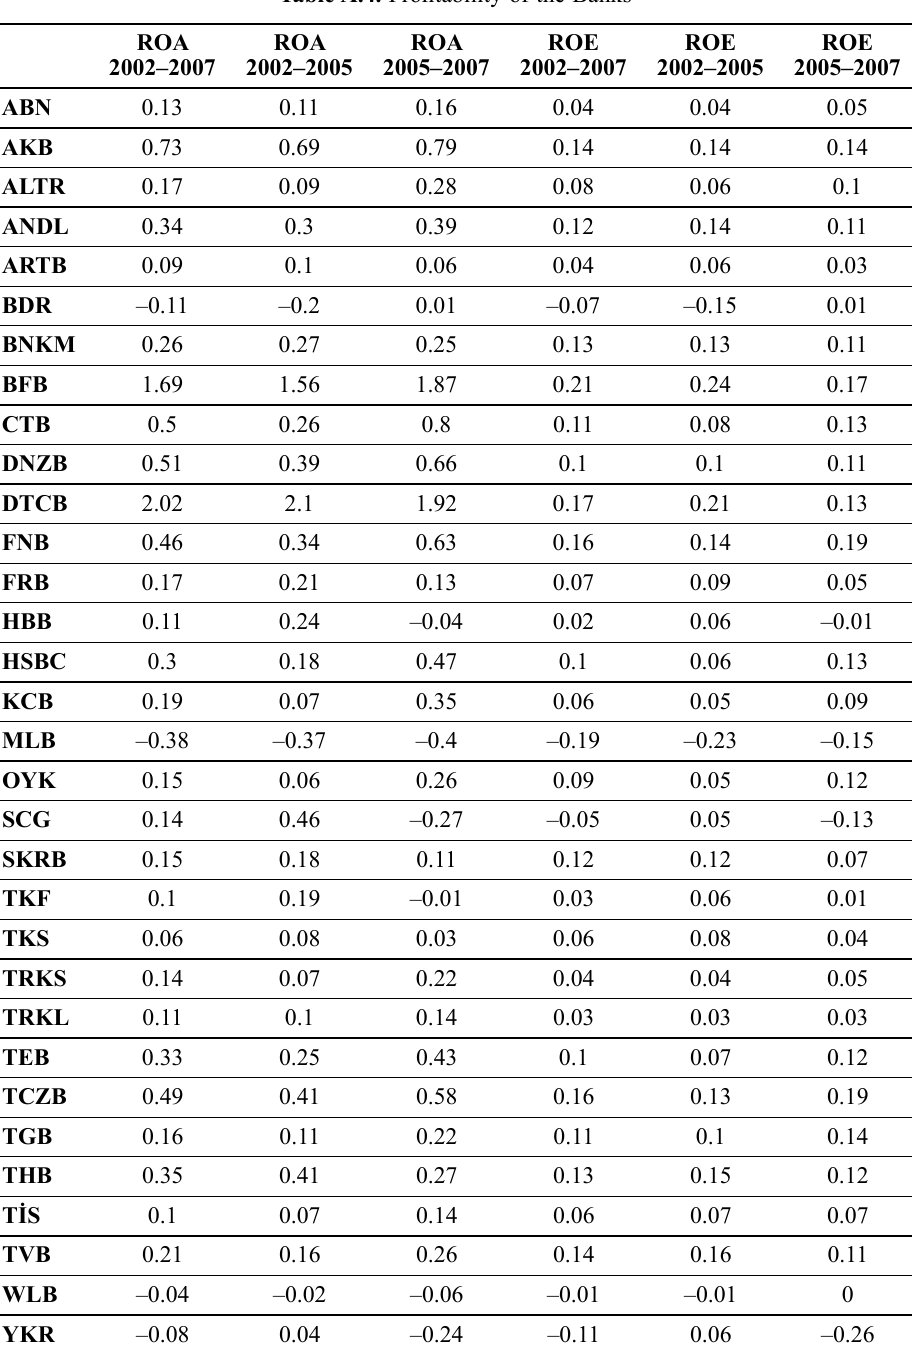
Table A.4. Profitability of the